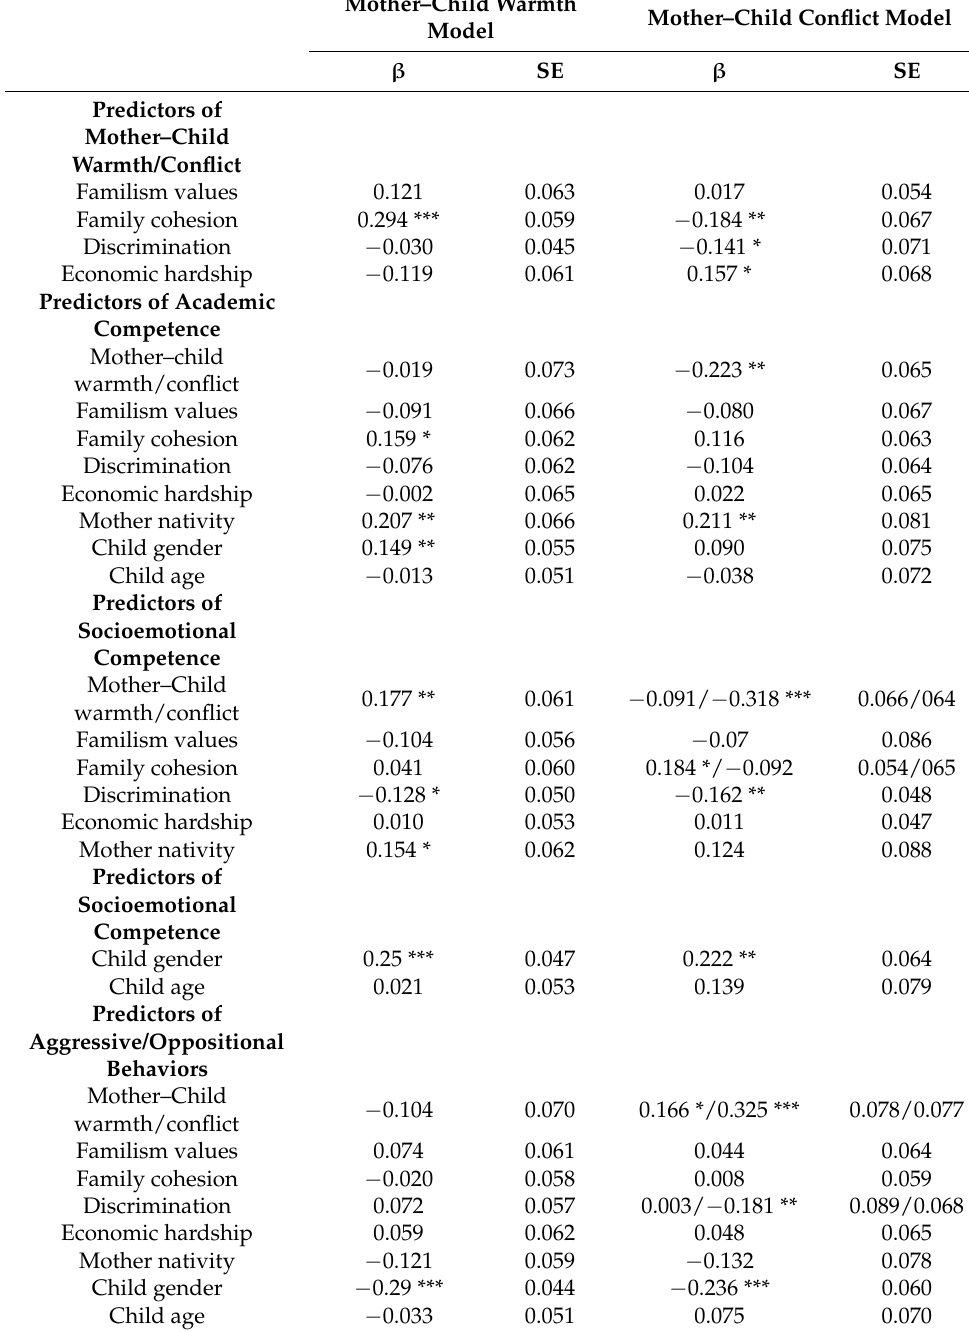
Table 2. Results for the associations between mothers’ cultural assets and challenges and children’s educational adjustment via mother–child warmth and